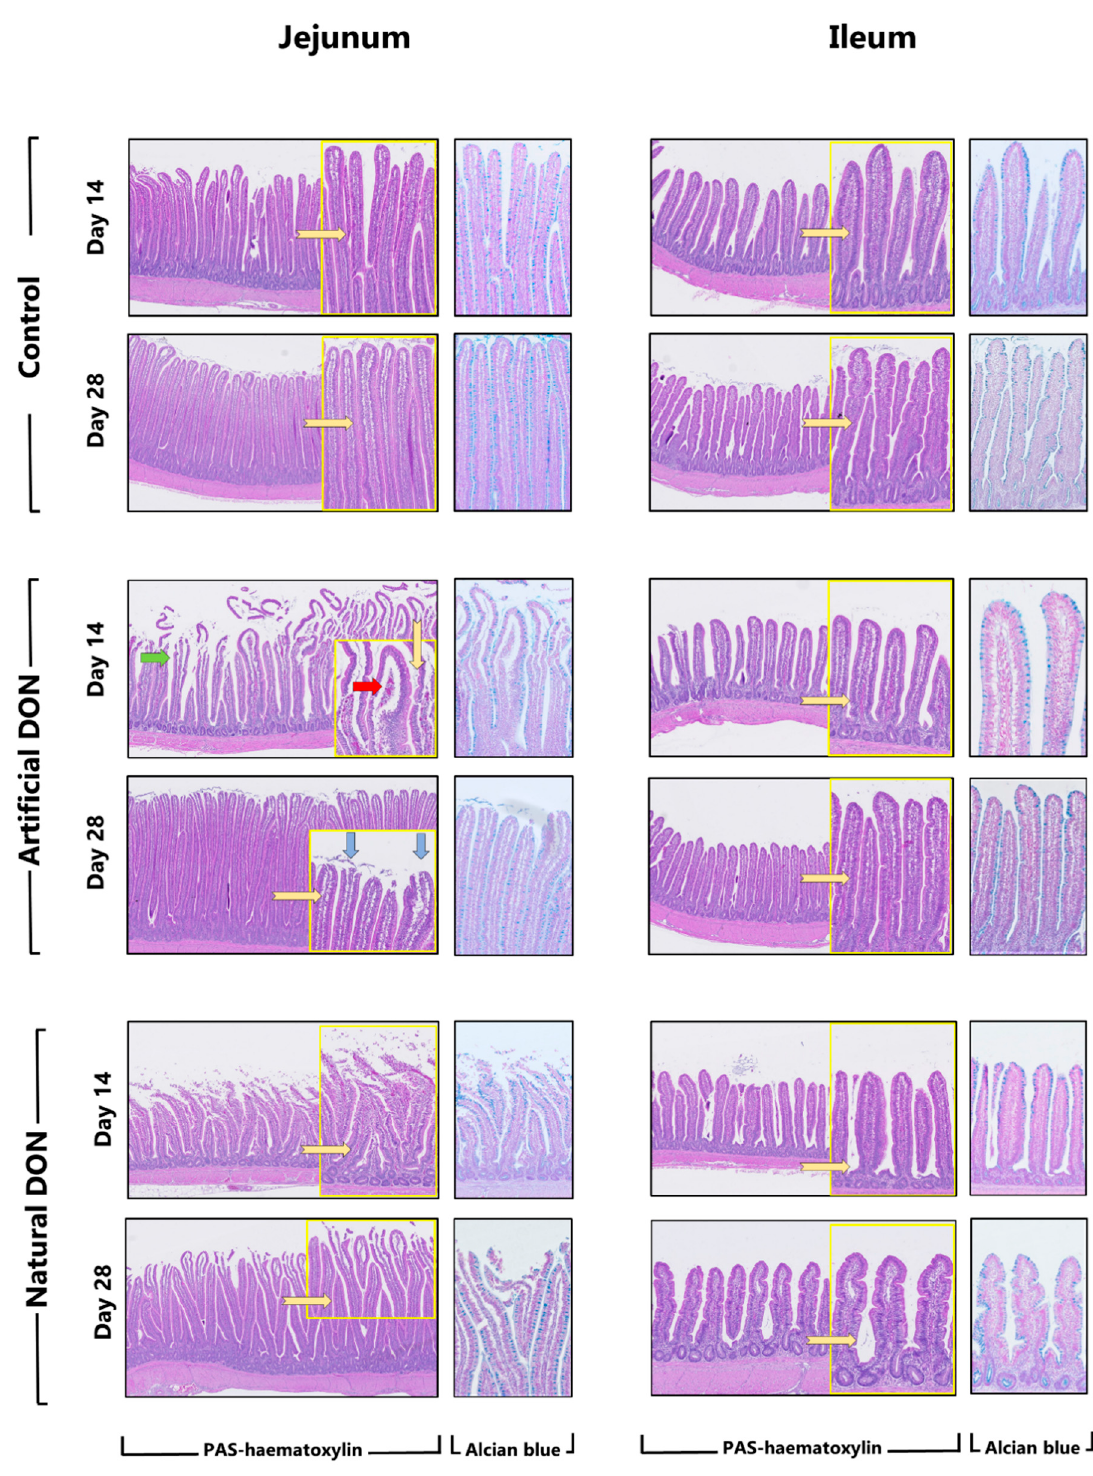
Figure 1. Illustrative images of periodic acid–Schiff (PAS)-hematoxylin- and Alcian blue stained sections of jejunum and ileum from broilers fed the experimental diets; magnification of 200×. Inserts in yellow boxes or with Alcian blue staining are zoomed from the original PAS-hematoxylin staining. The blue arrow indicates denudation of villi tips; the green arrow indicates extensive villus denudation, and the red arrow indicates dilated capillaries.